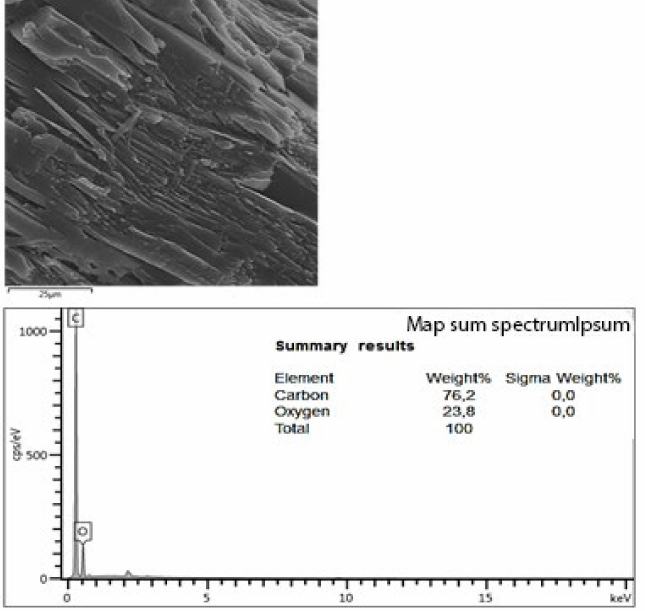
Figure 4. EDS image and corresponding spectrum of the total imaged area with weight